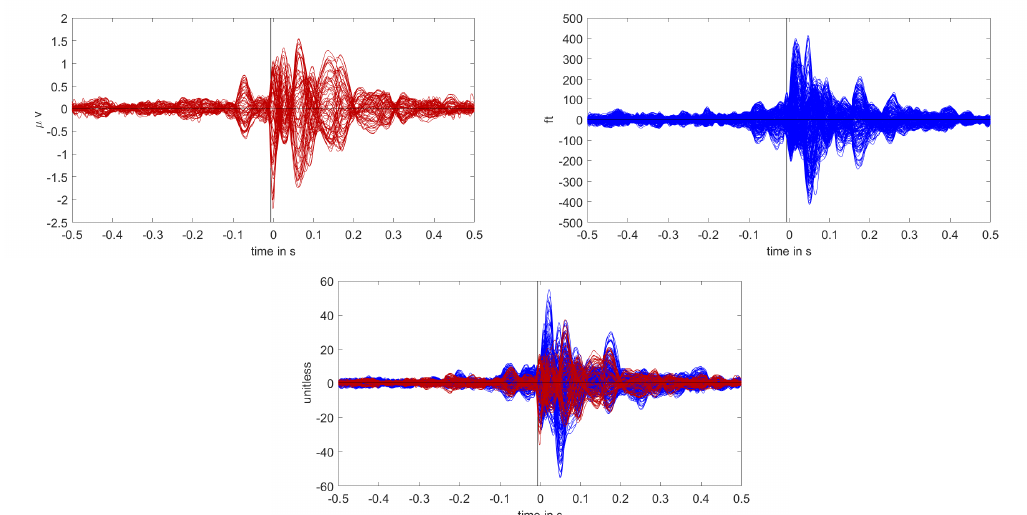
Figure 1. Butterfly plot of the averaged spikes of patient 1 in the EEG (red), MEG (blue), and MEEG (blue and red). The time point of the rising flank at − 6.6 ms is marked with a vertical line from above and below. The horizontal line marks the zero activity line.